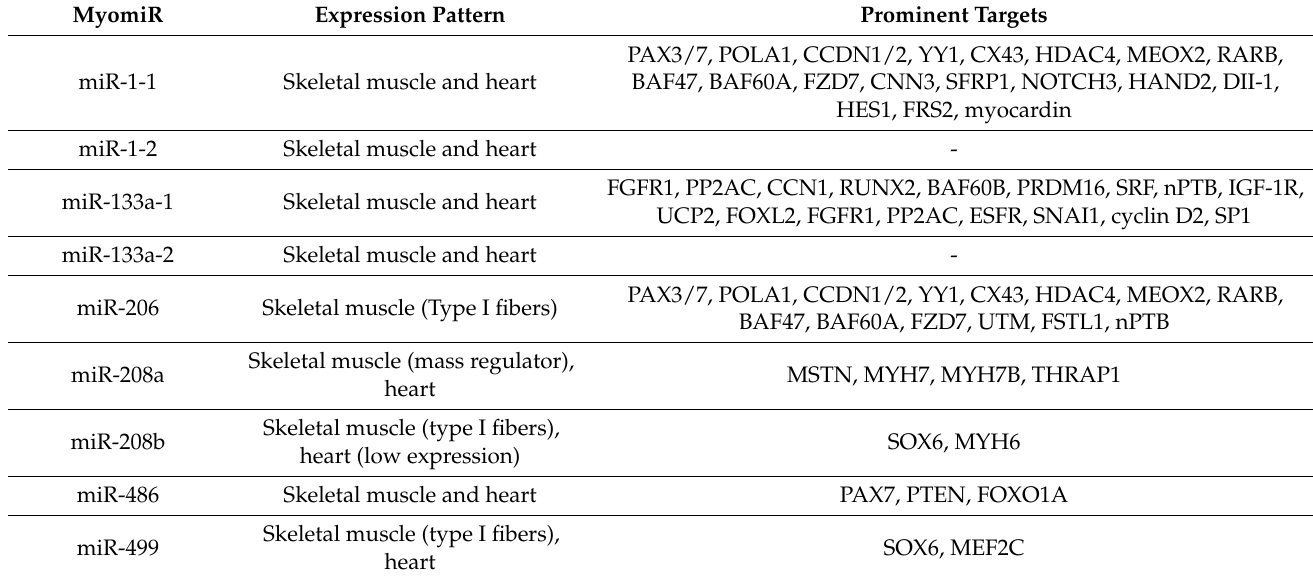
Table 1. MyomiRs, their expression patterns and prominent